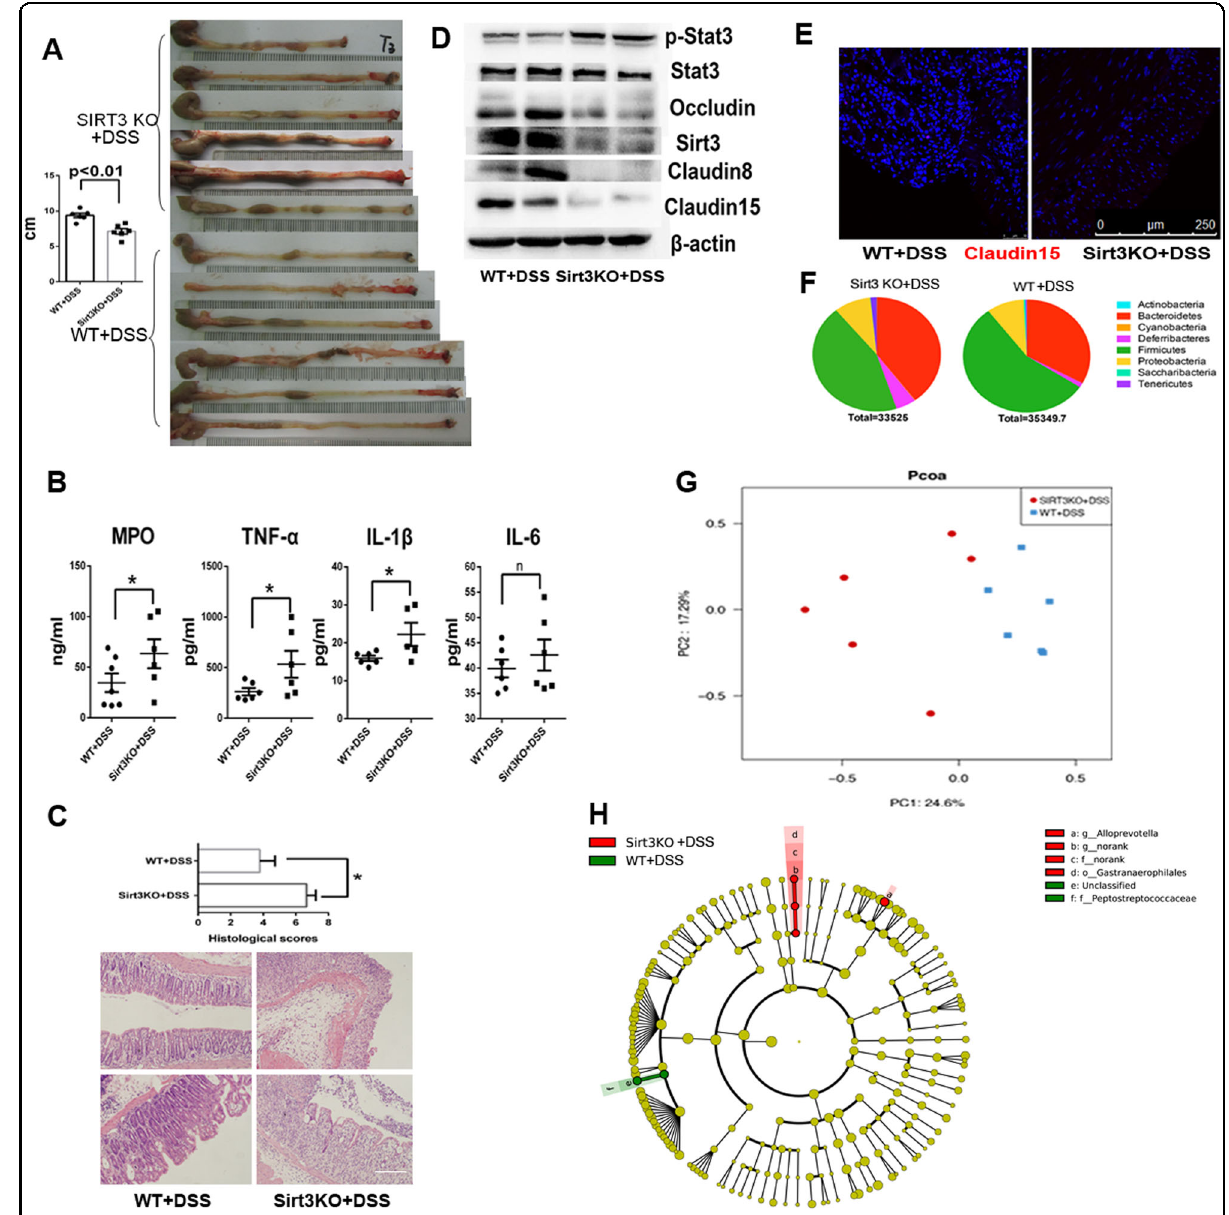
Fig. 1 Sirt3 de fi ciency results in colitis aggravation. a Gross pathology of SIRT3KO+DSS and WT+DSS mice colons on day 6 post-DSS. Note the extensive shortening in SIRT3KO mice ( n = 6). b In fl ammatory cytokine (MPO, IL-1 β , TNF- α and IL-6) levels in SIRT3KO and WT mice on day 6 post-DSS ( n = 6). Data are represented as the mean ± SEM. P < 0.05; ** P < 0.01; *** P < 0.001; by unpaired Student ’ s t test. c Western blots of intestinal epithelial proteins (Occuludin, Sirt3, Stat3, ph-Stat3, Claudin8 and Claudin15) from the colons of SIRT3KO or WT mice after treatment with DSS on day 6 post- treatment. d Histological scores and representative HE staining of distal colon sections obtained from SIRT3KO or WT mice after treatment with DSS.